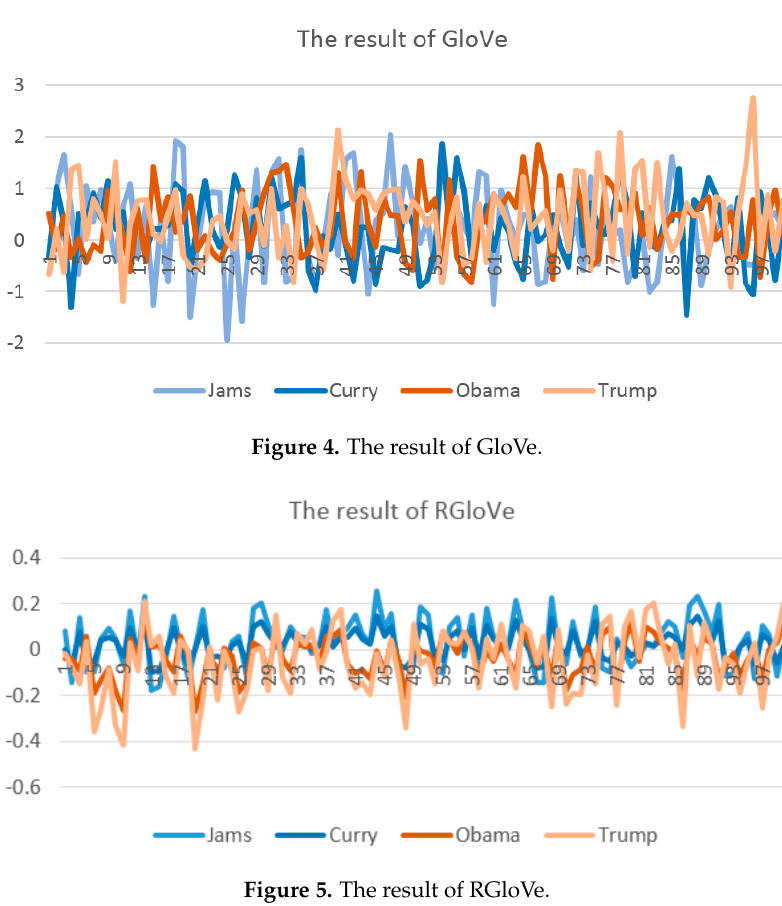
Figure 5. The result of RGloVe.